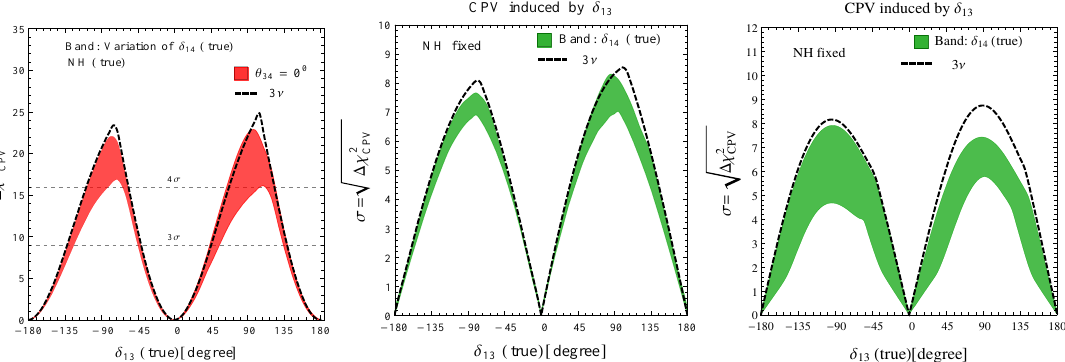
Figure 3. Sensitivity to CPV induced by δ 13 for DUNE ( left ), T2HK ( central ), and ESS ν SB ( right ) assuming the NMH is known to be the NH. In all three panels, the black dashed curve corresponds to the 3-flavor result. In the 4-flavor scheme, we fix the true and test values of θ 14 = θ 24 = 9 ◦ , and we take the true and test θ 34 to be 0 ◦ . In all panels, the colored bands are obtained in the 3 + 1 scheme by varying the unknown true δ 14 in the range of [ − π , π ] in the data while marginalizing over fit δ 14 in the same range. Figures taken from [45] ( left ), [50] ( central ), and [89] ( right